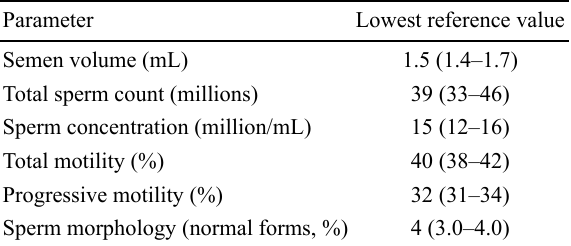
Table 1. Lowest reference values for semen analysis (5th percentile, 95% confidence